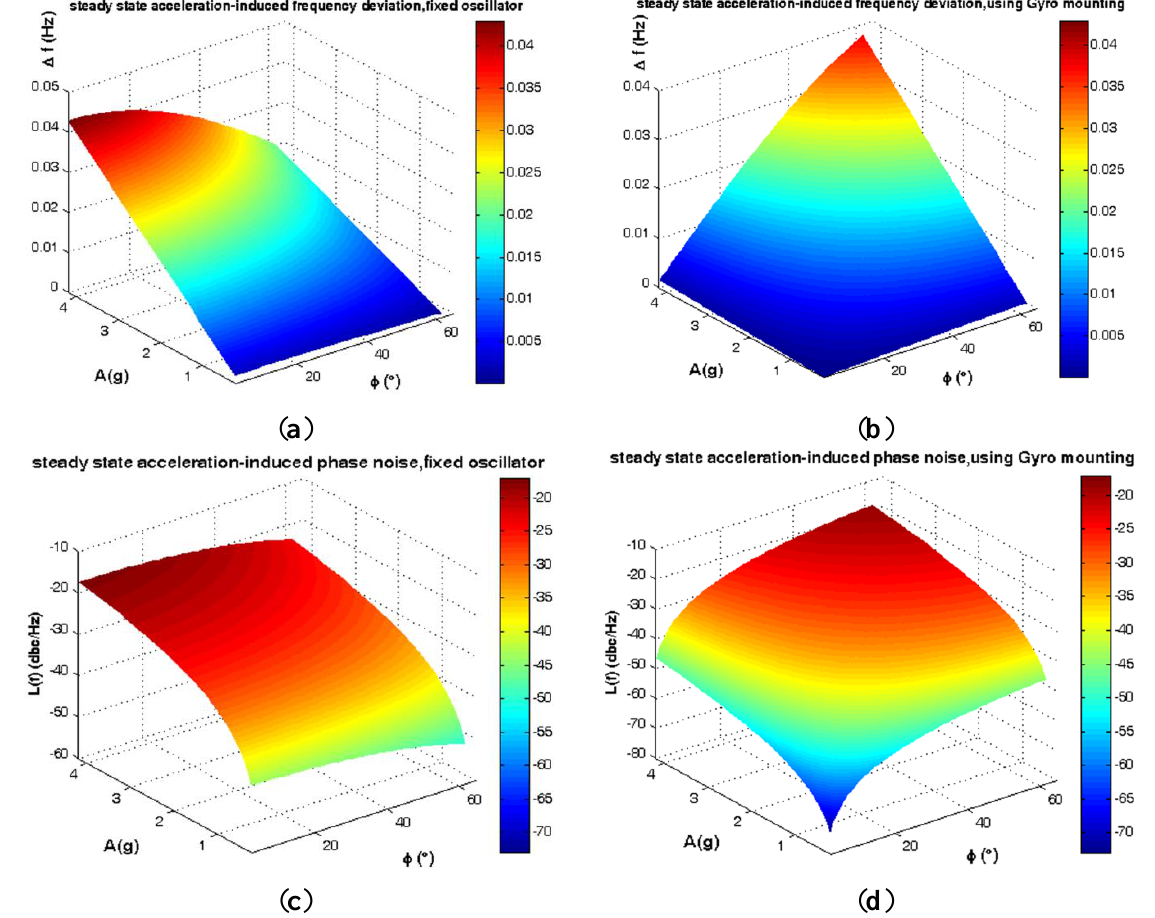
Figure 10. Short-term instability caused by steady state load in critical state β = 0. ( a ) Frequency deviation of fixed oscillator; ( b ) Frequency deviation of using gyroscopic mounting; ( c ) Phase noise of fixed oscillator; ( d ) Phase noise of gyroscopic